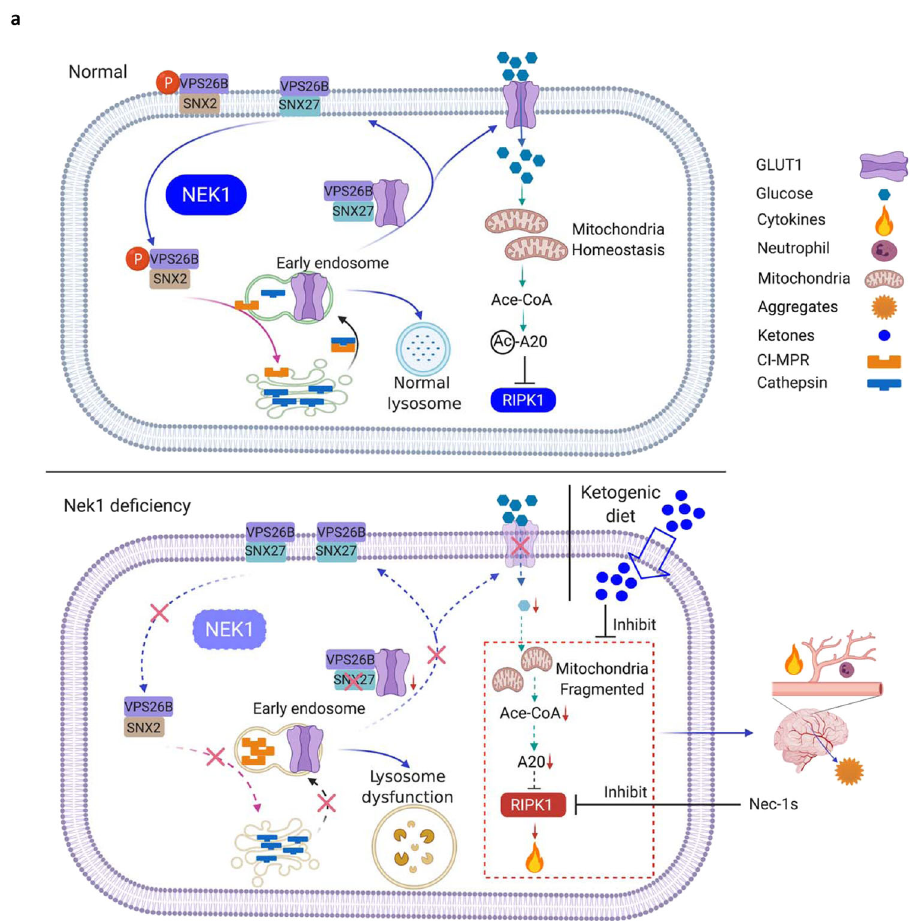
Fig. 8 A model for NEK1-regulated retromers that control the cell surface presence of membrane receptors, mitochondrial metabolism and RIPK1- mediated cell death and in fl ammation. Phosphorylation of S302/S304 VPS26B by NEK1 modulates the recycling of SNX27-retromer and SNX2-retromer that deliver proteins from endosomes to cell surface membrane and lysosomes. NEK1 de fi ciency blocks the recycling of SNX27-retromer from cell surface to endosomes. Since SNX27-retromer is important for delivering GLUT1 to the cell surface membrane, NEK1 de fi ciency leads to reduced GLUT1 levels at the cell surface membrane which reduces glucose uptake. Reduced glucose uptake disrupts mitochondrial metabolism and reduces cellular levels of acetyl- CoA. Reduced acetyl-CoA inhibits the acetylation of A20 which promotes its lysosomal degradation. Reduced levels of A20 sensitizes to the activation of RIPK1-dependent cell death and in fl ammation which can be inhibited by Nec-1s and also by ketogenic diet which provides alternate source of acetyl-CoA to restore cellular levels of neurodegenerative diseases, our study suggests that the regulation of different subtypes of retromer complexes, such as the phos- and PD, but also ALS as shown in this study. Although it remains the speci fi city of neuropathology. Overall, our study suggests the